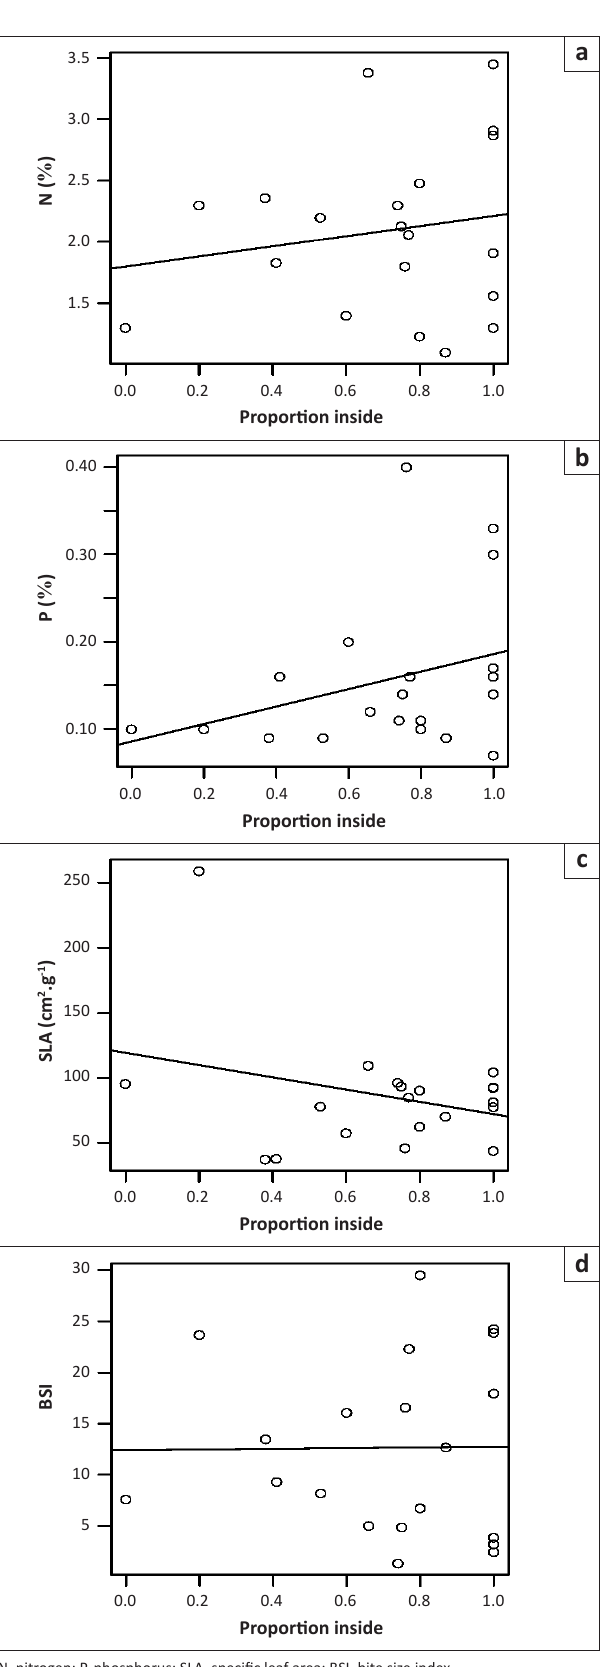
FIGURE 6: Data for, (a) leaf nitrogen, (b) leaf phosphorus, (c) specific leaf area and (d) bite size index plotted against the proportion of species found on the inside compared to the outside of three exclosures in the Kruger National Park. A value of 1 indicates that the species was only found inside, whilst a value of 0 indicates the species was only found outside the